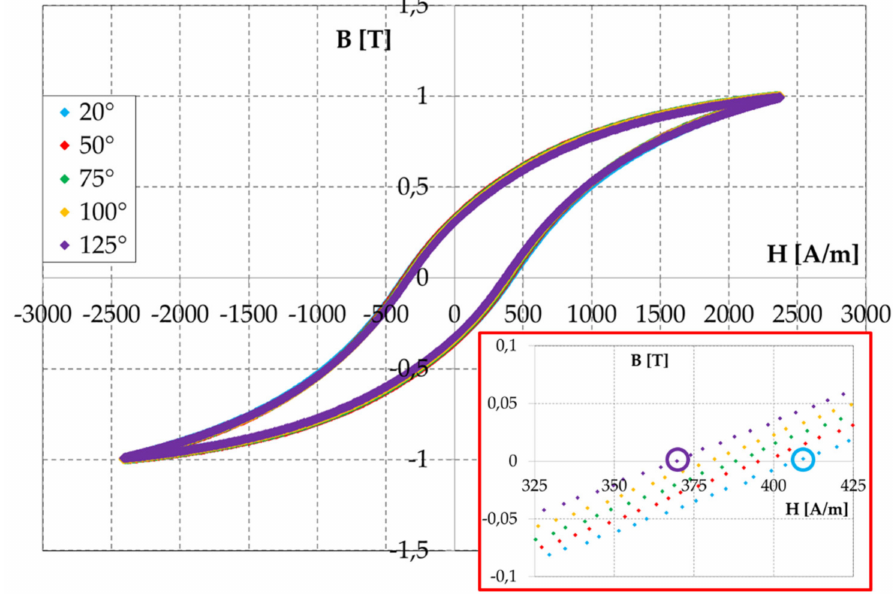
Figure 13. Hysteresis cycles at different temperatures of SMC sample E 0.5-700 for different